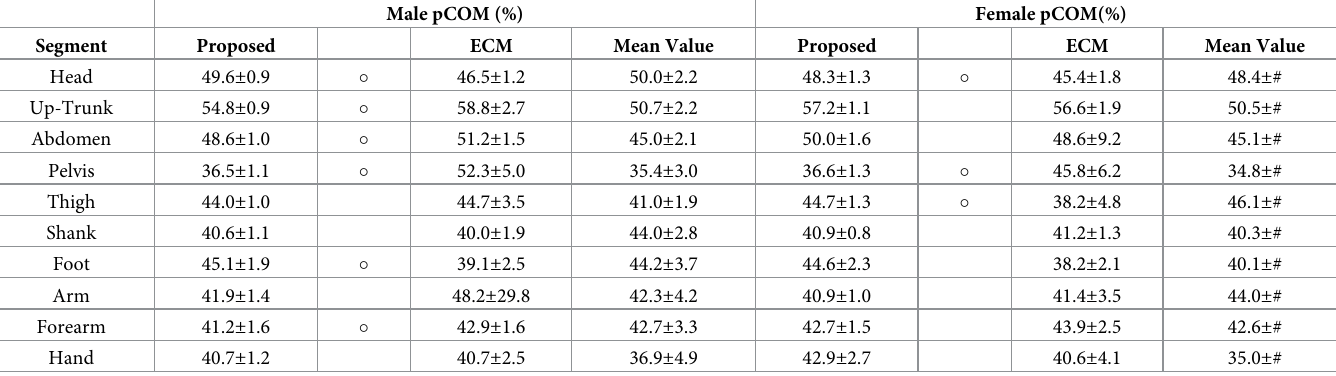
Table 6. Center of mass position from the proximal endpoints (pCOM) (mean ± SD in %) estimated using the proposed method and the ECM approach for both male and female participants. Male pCOM (%) Female pCOM(%)